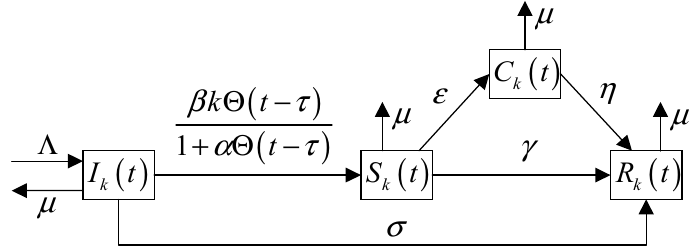
Figure 1. Flowchart of an ISCR rumor model.